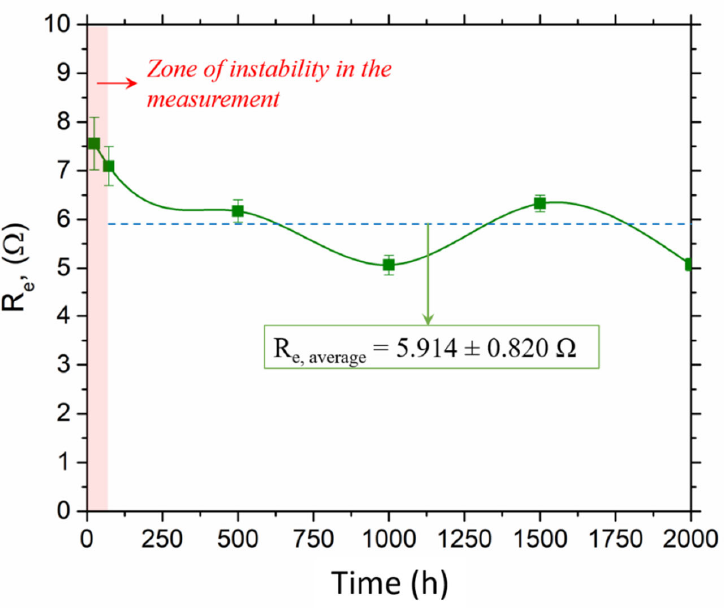
Figure 6. Variation in the resistance of the electrolyte (R e ) during testing. Table 2. Values of each of the equivalent circuit elements in compliance for each testing time with the protective layer model.